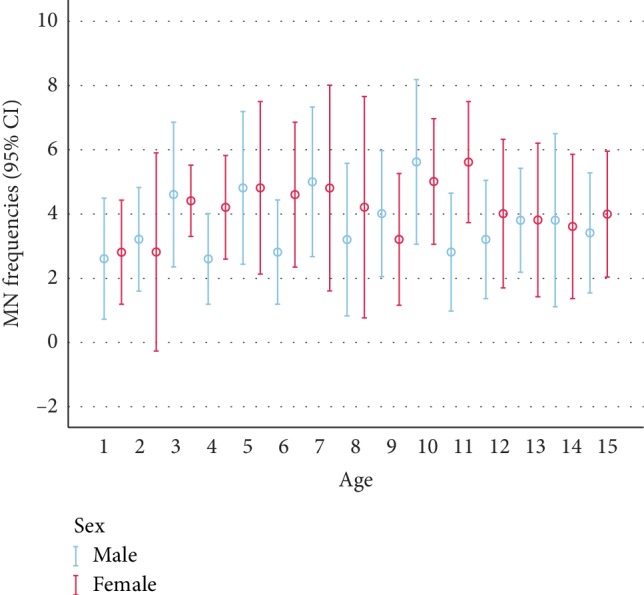
Error bar chart representing the MN frequencies, ages, and sexes of the study group. The frequency of MN dispersed evenly among sex and age (95% confidence interval) (MN: micronucleus, CI: confidence interval).